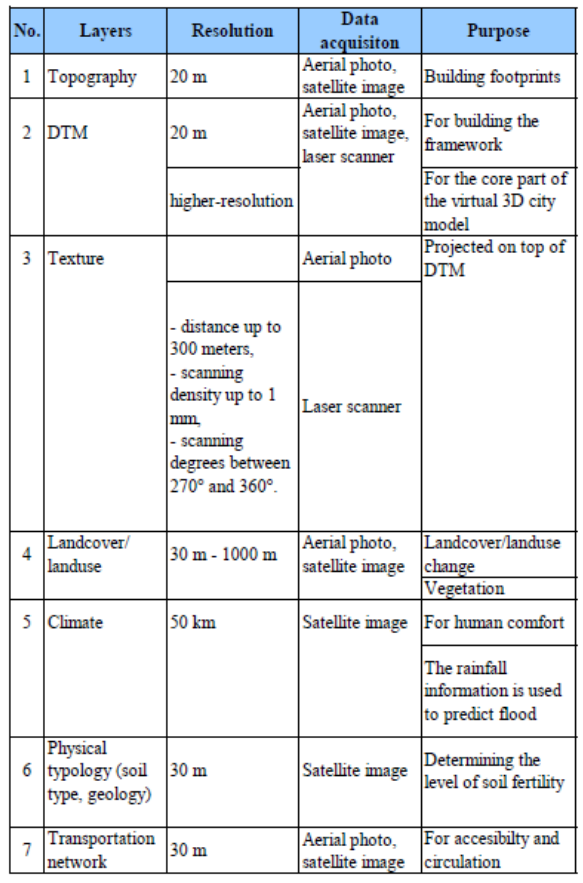
Table 2 Data resolution and their data acquisition technique